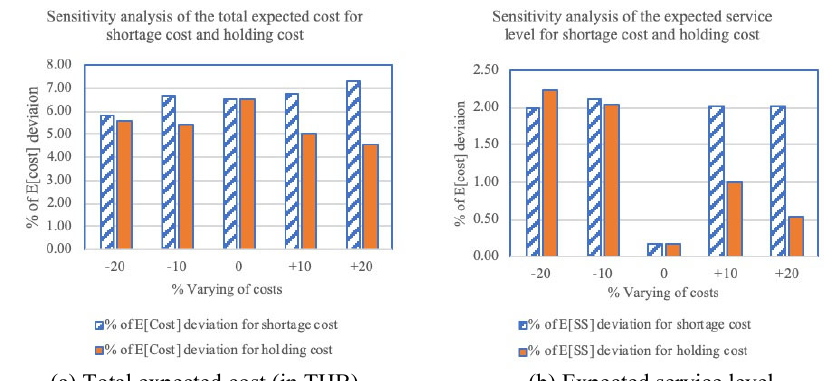
Fig. 13. Sensitivity analysis of the efficiency of tabu search for varying shortage and holding